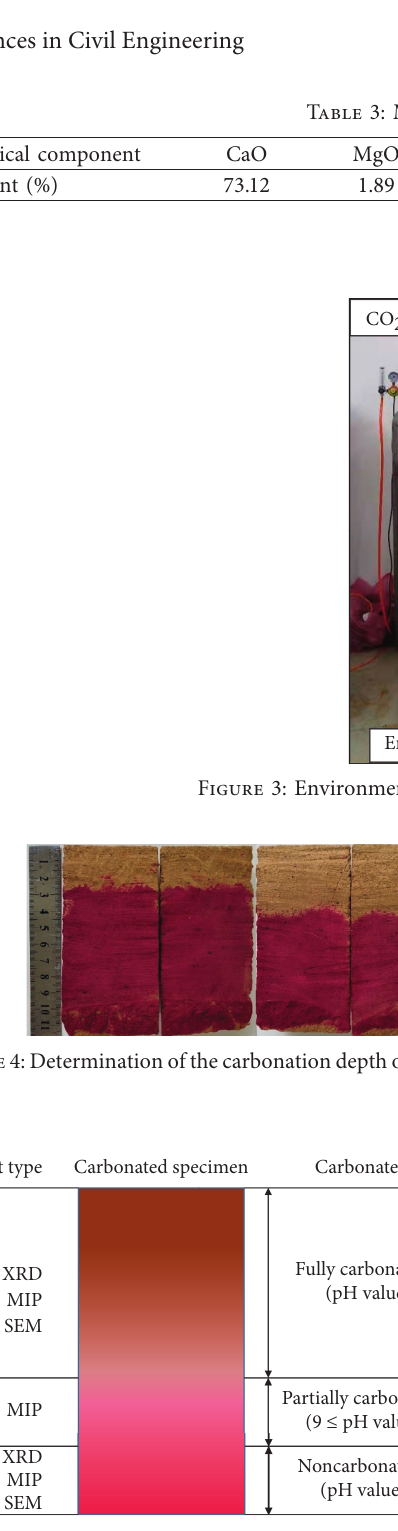
Figure 5: Sampling locations for microstructural analysis of the